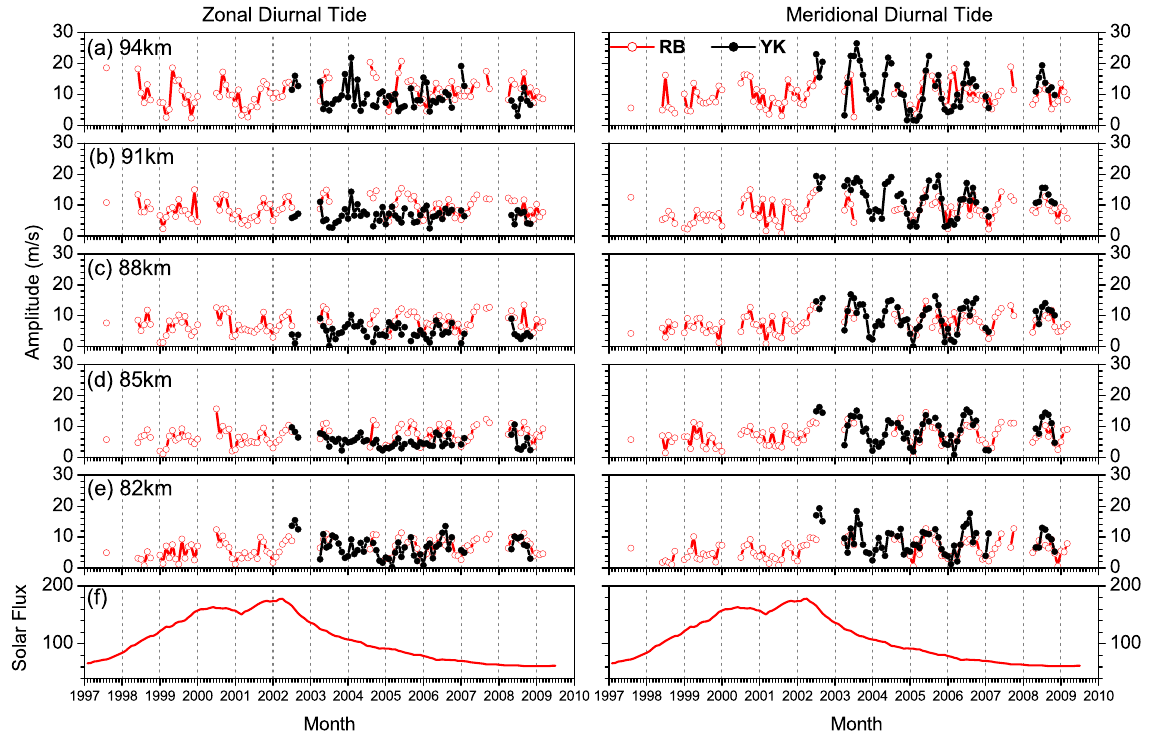
Fig. 5. Similar to Fig. 3, but for diurnal tidal